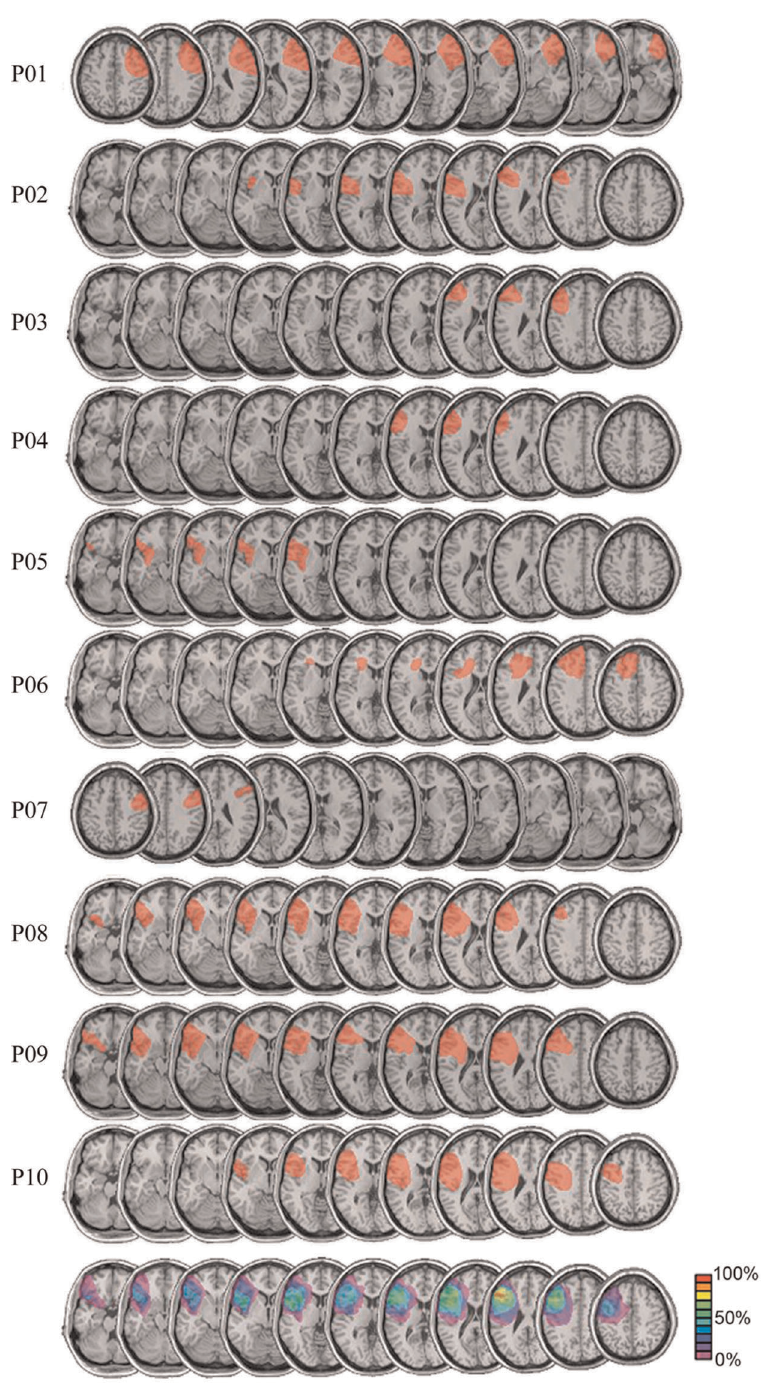
Figure 1. Patient MRIs. Lesion reconstructions are show for individual patients [n=10], and we include a group average overlay (bottom). MRI reconstructions were obtained using MRIcro [32]. For the group average, patients with right hemisphere lesions [P01 and P07] were transcribed to the left hemisphere for display purposes. The color bar indicates the percent of patients with a lesion in a specific region. The area of greatest lesion overlap across the patients occurs in Brodmann areas 9 and 46, centered in the middle frontal gyrus.